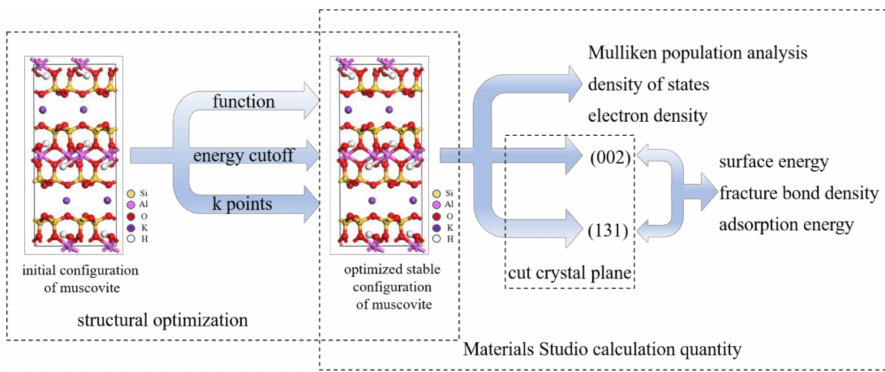
Figure 1. Flow chart of the theoretical